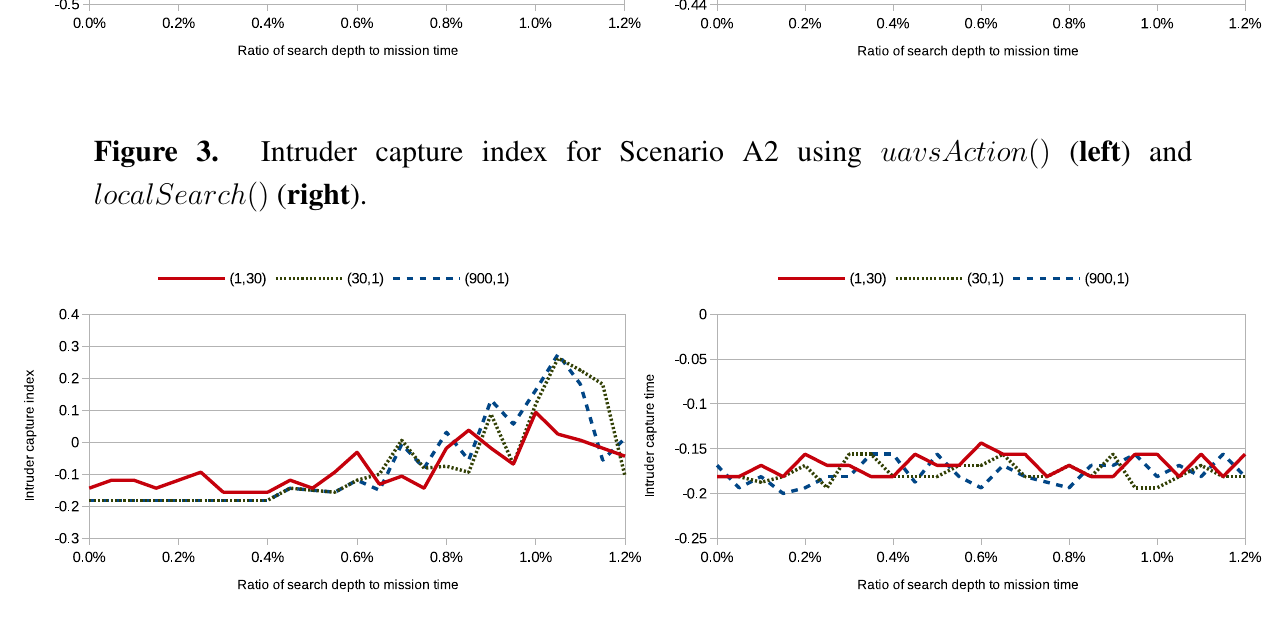
Figure 4. Intruder capture index for Scenario A3 using uavsAction () ( left ) and localSearch () ( right